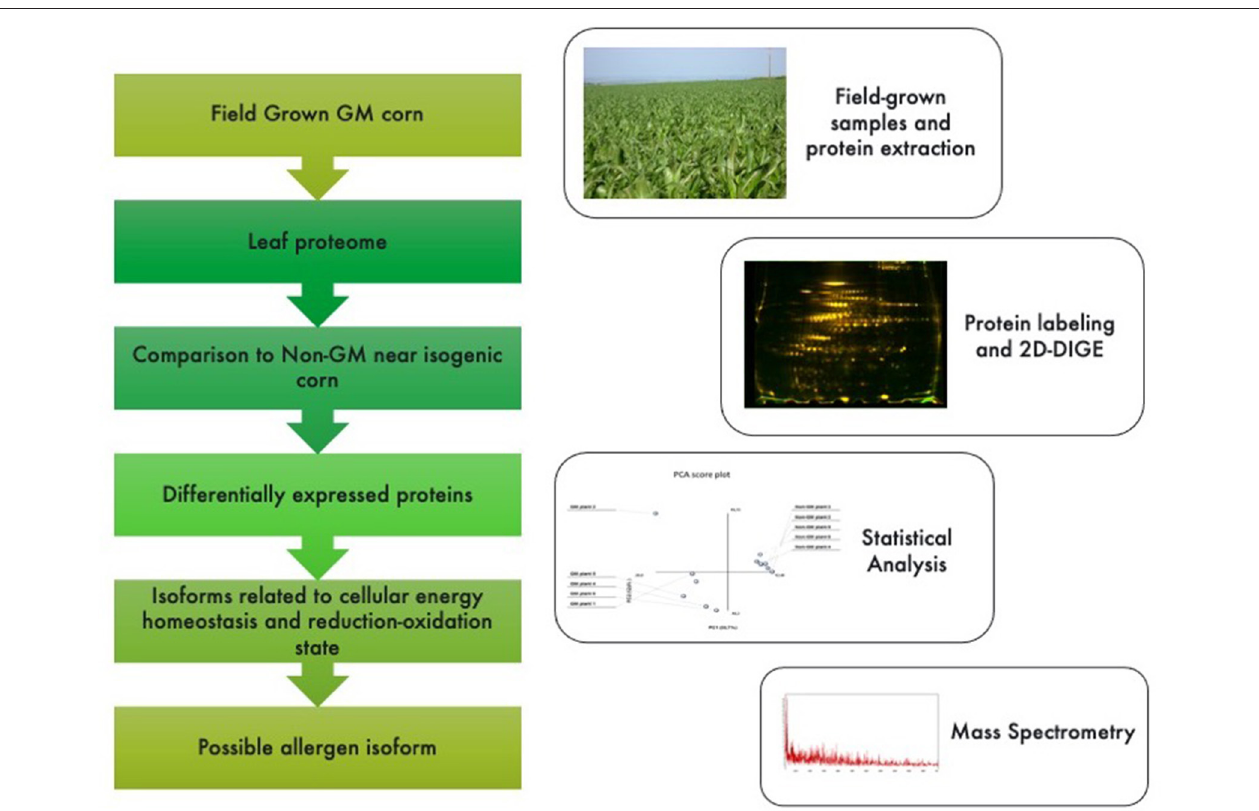
FIGURE 1 | Graphical abstract and methodological pipeline for this study. Proteomic profiling analysis was performed for GM vs. non-GM maize samples expressing the Cry1Ab cassette. Plants were field grown in South Africa and subjected to a phenol-based protein extraction. 2-D fluorescent gels were analyzed and statistically significant spots ( < 0.05%) were sequenced by MSMS analysis. Identified proteins were then searched against public databases for their annotations.